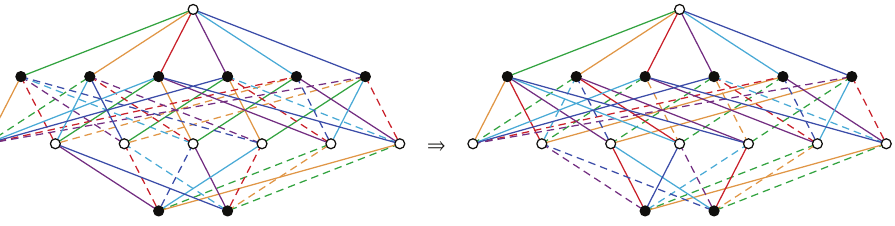
Figure 11: Adinkra after steps (ii) and (iii).